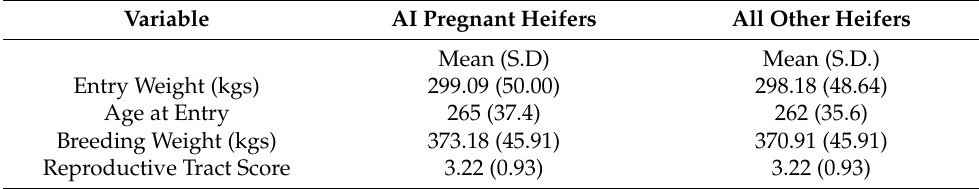
Table 1. Descriptive statistics of replacement beef heifers (AI pregnant vs. all other